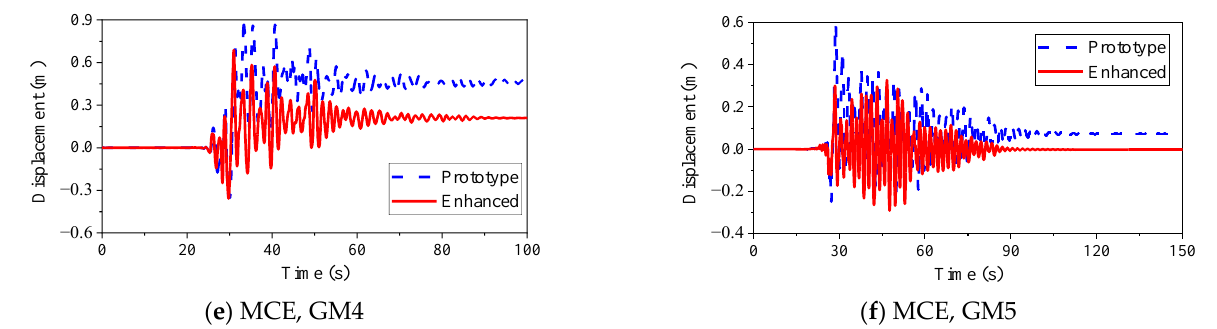
Figure 19. Comparison of the roof drift time history curves.